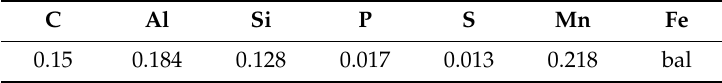
Table 1. Chemical element composition of Q235B steel